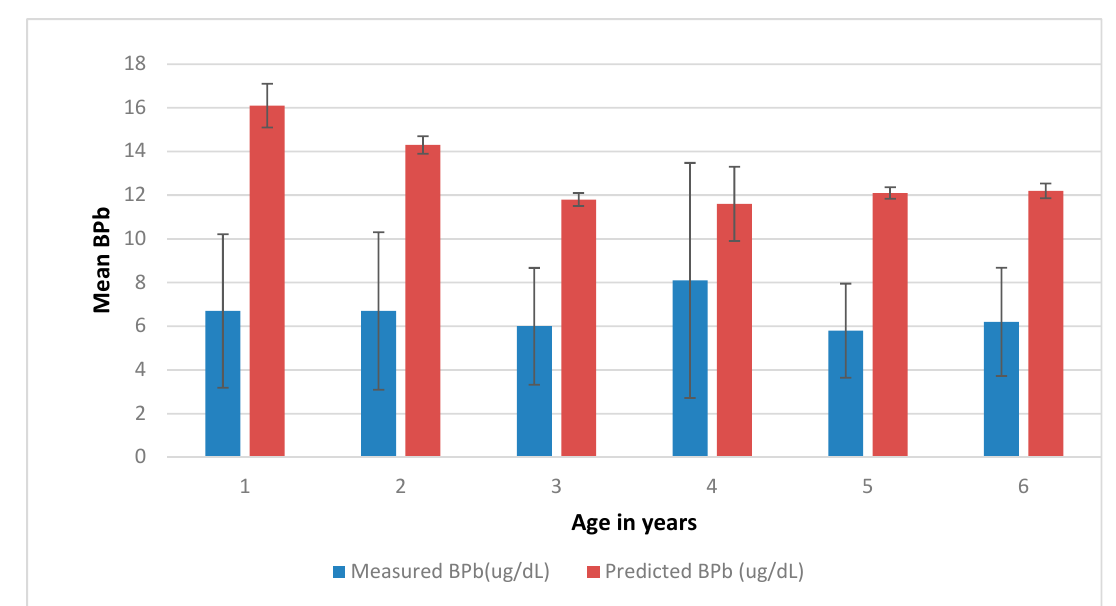
Figure 1. Comparison of the geometric means predicted and mean observed BPb against age (for 50% food bioavailability and a default 30% soil bioavailability).